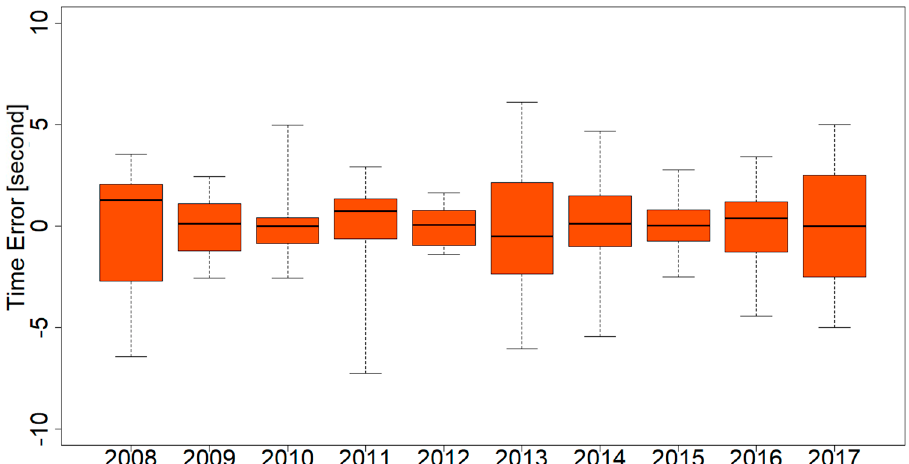
Figure 7. Yearly change of the time error for Electric Reliability Council of Texas (ERCOT) system of North America from 2008 to 2017. One typical month is selected to represent every year. The box-plot depicts the maximum and minimum time error (the ends of the whiskers), the first and third quartiles (the bottom and top of the box), and the mean time error (the band inside the box).